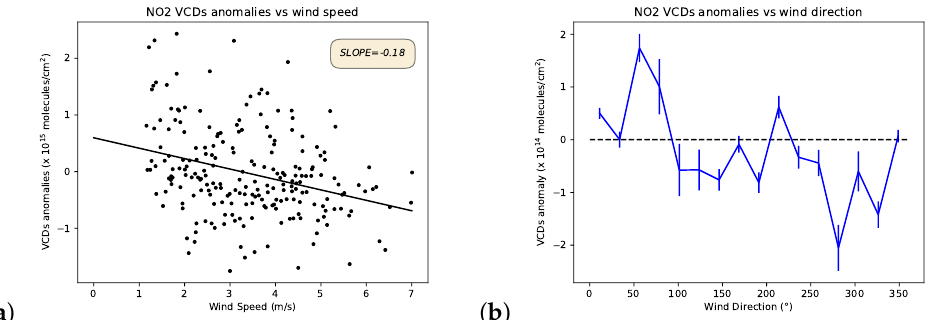
Figure 10. NO 2 VCDs anomalies with respect to the wind speed ( a ) and wind direction ( b ) measured at 20 m. In figure ( b ), the wind directions are indicated clockwise with 0 ◦ representing the north. Lecce is located in the northeast direction, where the peak is found.